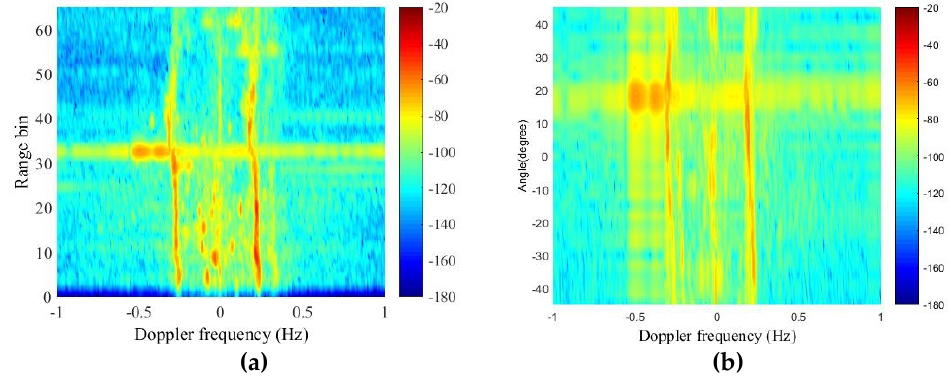
Figure 5. Range-Doppler frequency map: ( a ) range-Doppler map with the beam pointing to 21°; ( b ) angle-Doppler map in the 34th range bin